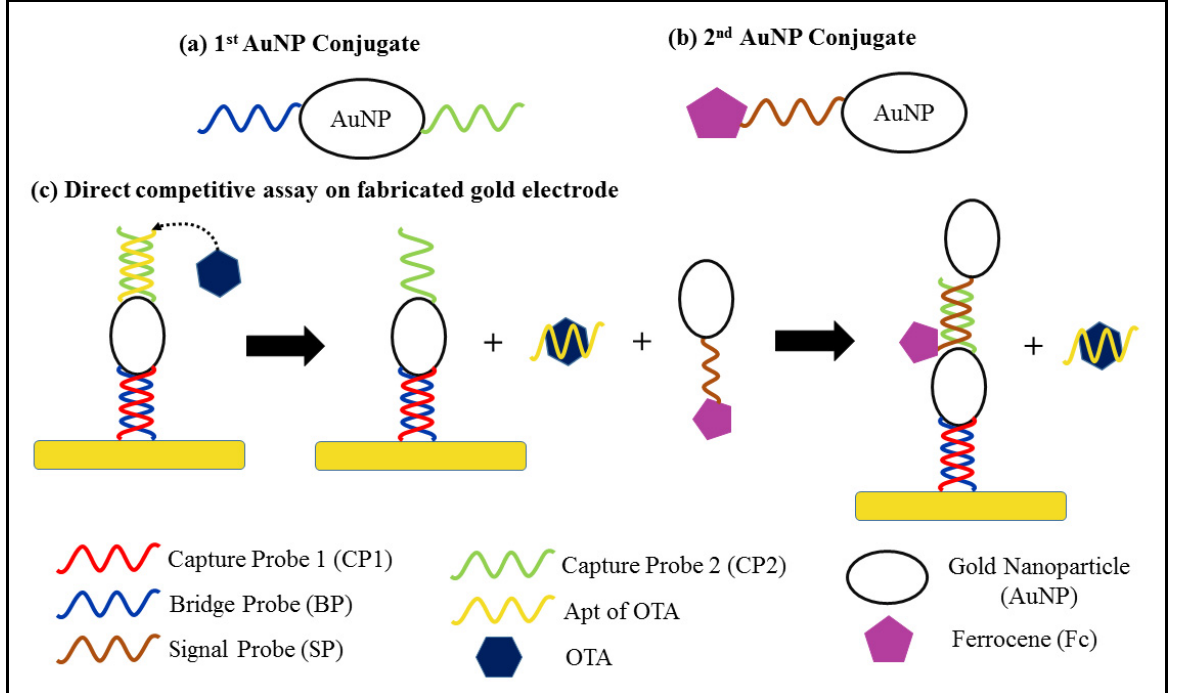
Figure 4. Schematic diagram of the ( a ) structure of the first AuNP conjugate ( b ) structure of the second AuNP conjugate and ( c ) indirect competitive detection of OTA.